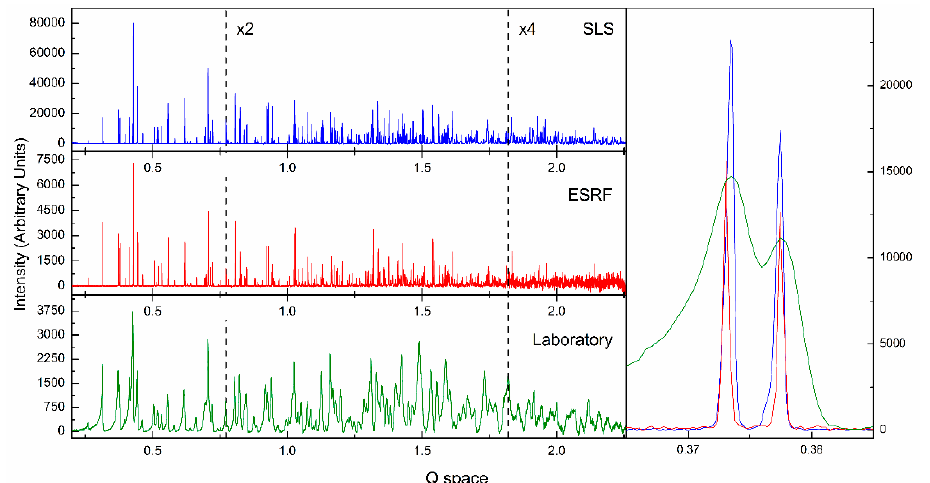
Figure 15. Overplot of three octreotide datasets, collected at different sources, in a restricted angle region (Q = 4 π · sin θ · λ − 1 ). The right panel shows the first two peaks for each source, indicating their individual properties.